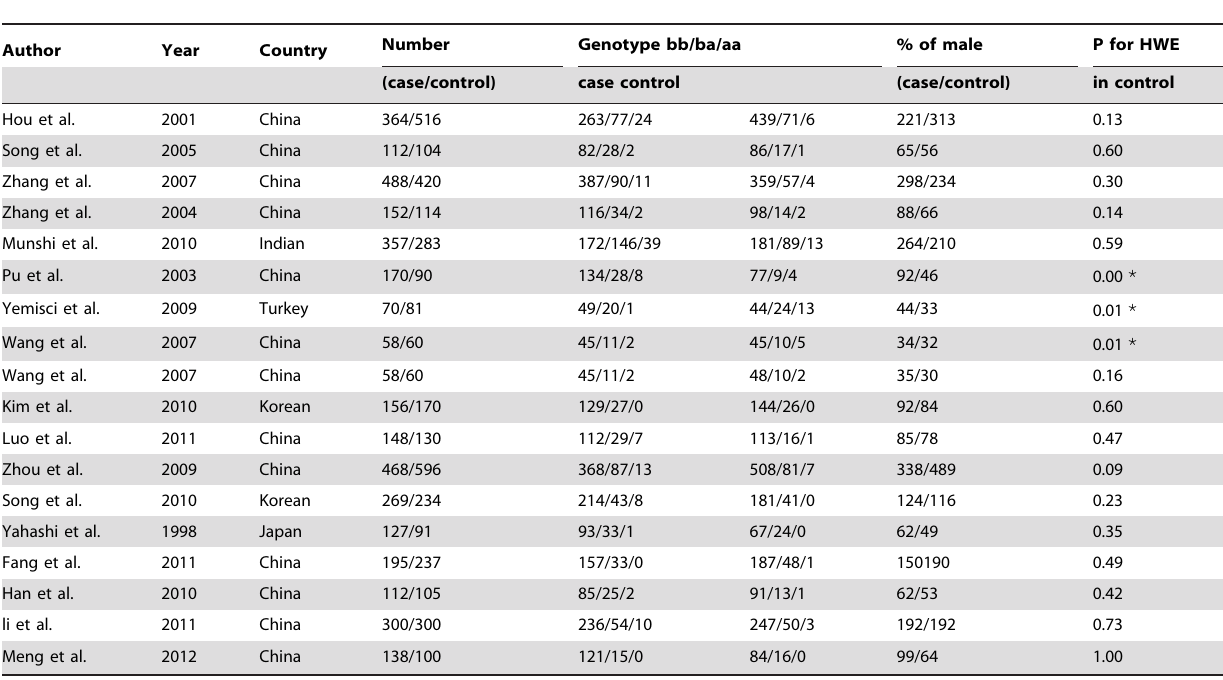
Table 1. Characteristics of eNOS gene 4b/a polymorphism genotype distributions in studies included in this